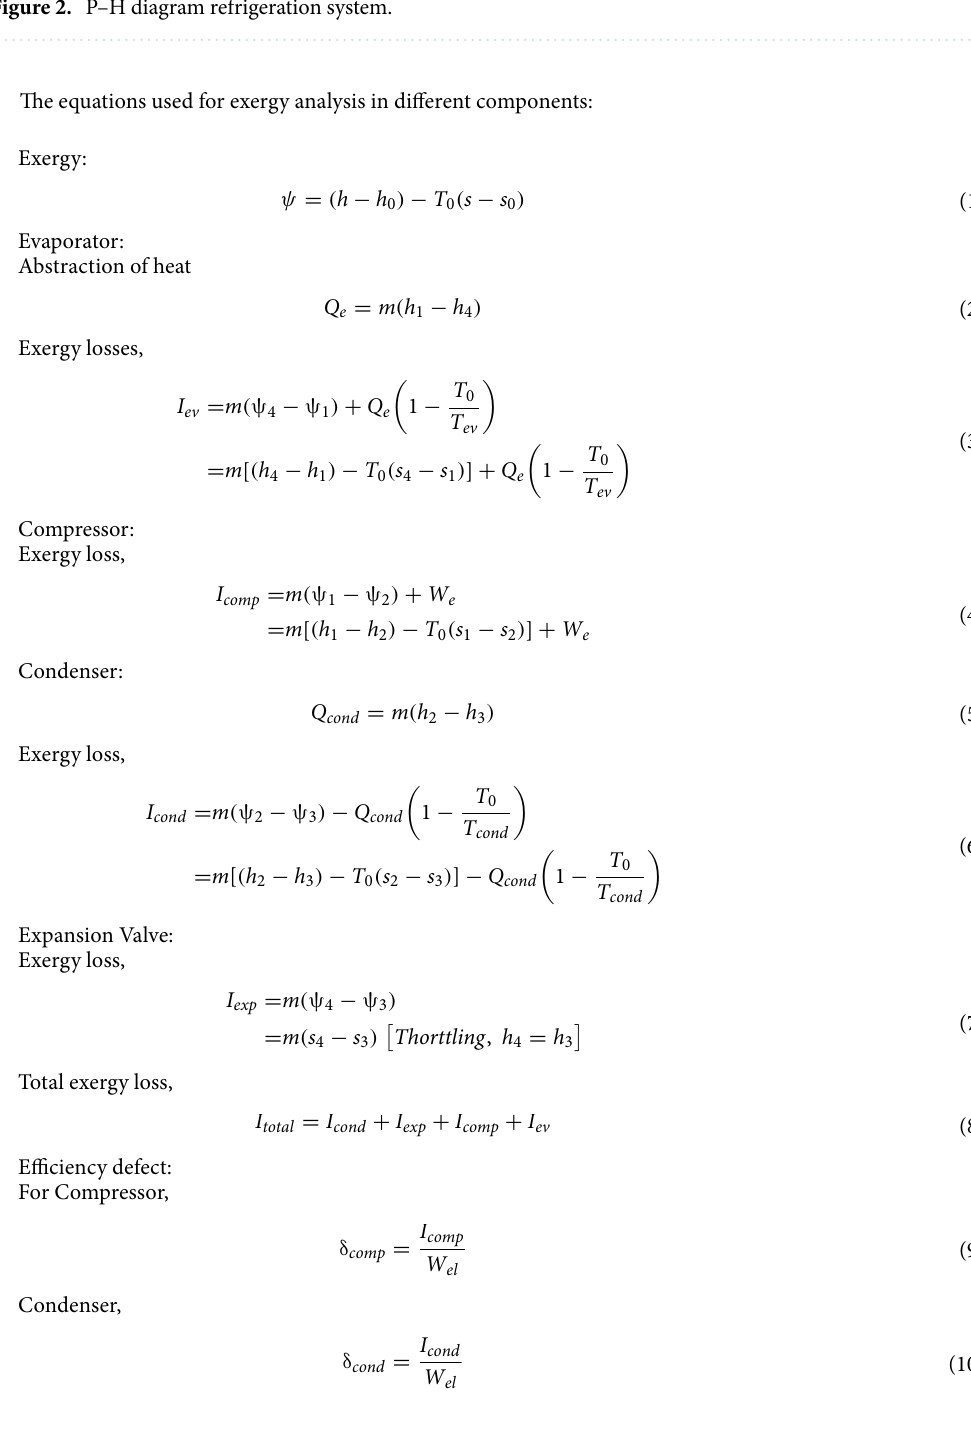
Figure 2. P–H diagram refrigeration